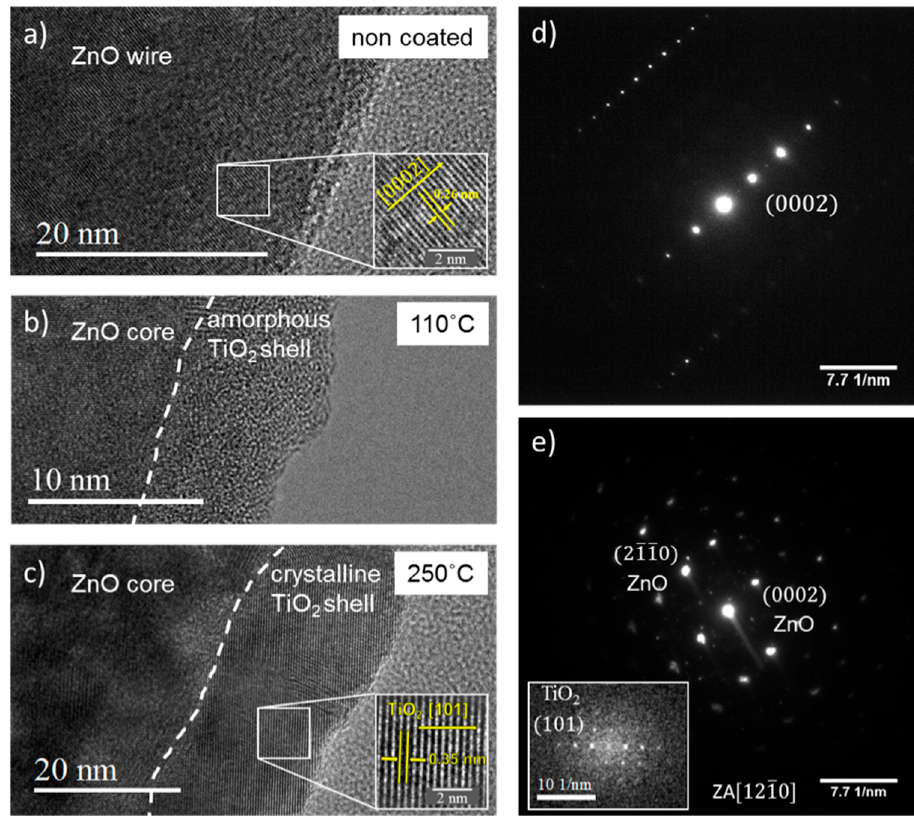
Figure 4. High resolution transmission electron microscopy (HRTEM) images of ( a ) ZnO and ( b , c ) ZnO/TiO 2 nanowires. The TiO 2 layer was synthesized by ALD at ( b ) 110°C and ( c ) 250 °C. The insets show high magnification images with measured d -spacings of 0.26 nm ( a ) and 0.35 nm ( c ) corresponding to the crystallographic planes of ZnO (0002) and anatase TiO 2 (101), respectively. SAED patterns in ( d , e ) correspond to the ZnO and ZnO/TiO 2 nanowires shown in ( a , c ), respectively. The inset in ( e ) shows the Fourier transform image of the crystalline TiO 2 shell deposited at 250 °C.